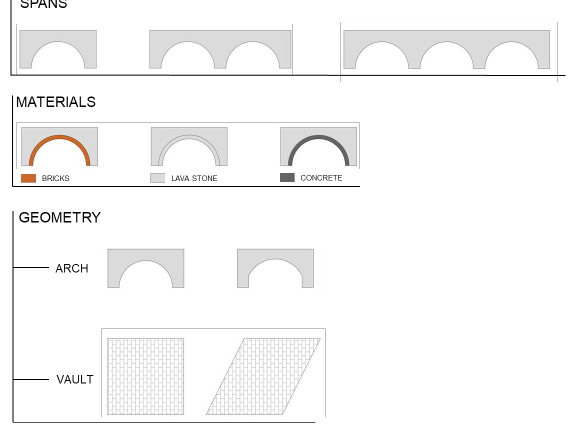
Figure 1 . Conceptual schematization of the characteristics of the Circumetnea